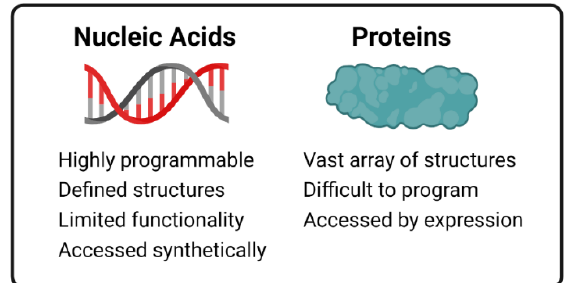
Figure 1. Comparison of nucleic acids and proteins as molecular building